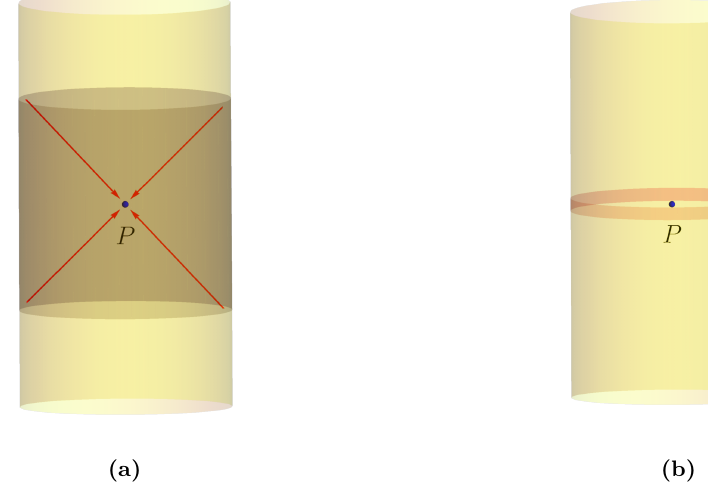
Figure 1. A common misunderstanding of “holography” is that it only tells us that data on the timelike boundary of AdS can be used to reconstruct physics at the bulk point P as shown in the left subfigure. But this statement follows from the causal structure of AdS and does not require holography. Gravitational theories are genuinely holographic. In this paper we show how, in gravity, data on an infinitesimal time band (right subfigure) can be used to reconstruct physics in the bulk. in a non-gravitational theory, it is impossible to distinguish a given state from the state obtained after the action of such a